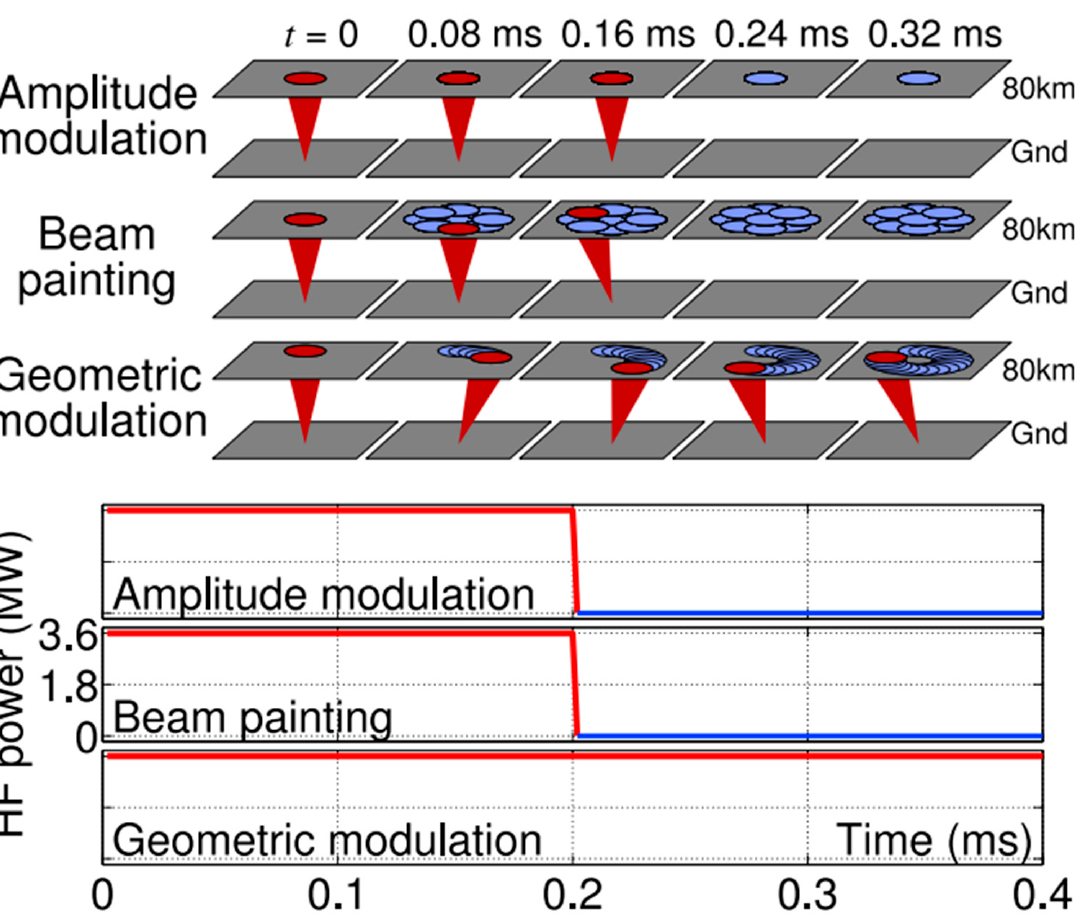
Figure 4. Schematic comparison of AM, Beam Painting (BP), and Geometric Modulation (GM). (top) The progression of the high frequency (HF) beam at five points during an ELF/VLF period (which is 0.4 ms for f = 2.5 kHz). Bottom panel indicates the cases of AM and BP when the HF transmitter is turned ON and OFF with a duty cycle of 50%. In the GM case, no power modulation is involved; instead, the constant beam results in a slower sweep along a geometric shape, in this case, a circle (reproduced with permission from Cohen, M.B., Inan, U.S., Gołkowski, M., McCarrick, M.J., ELF/VLF wave generation via ionospheric HF heating: Experimental comparison of amplitude modulation, beam painting, and geometric modulation; published by John Wiley and Sons, 2010